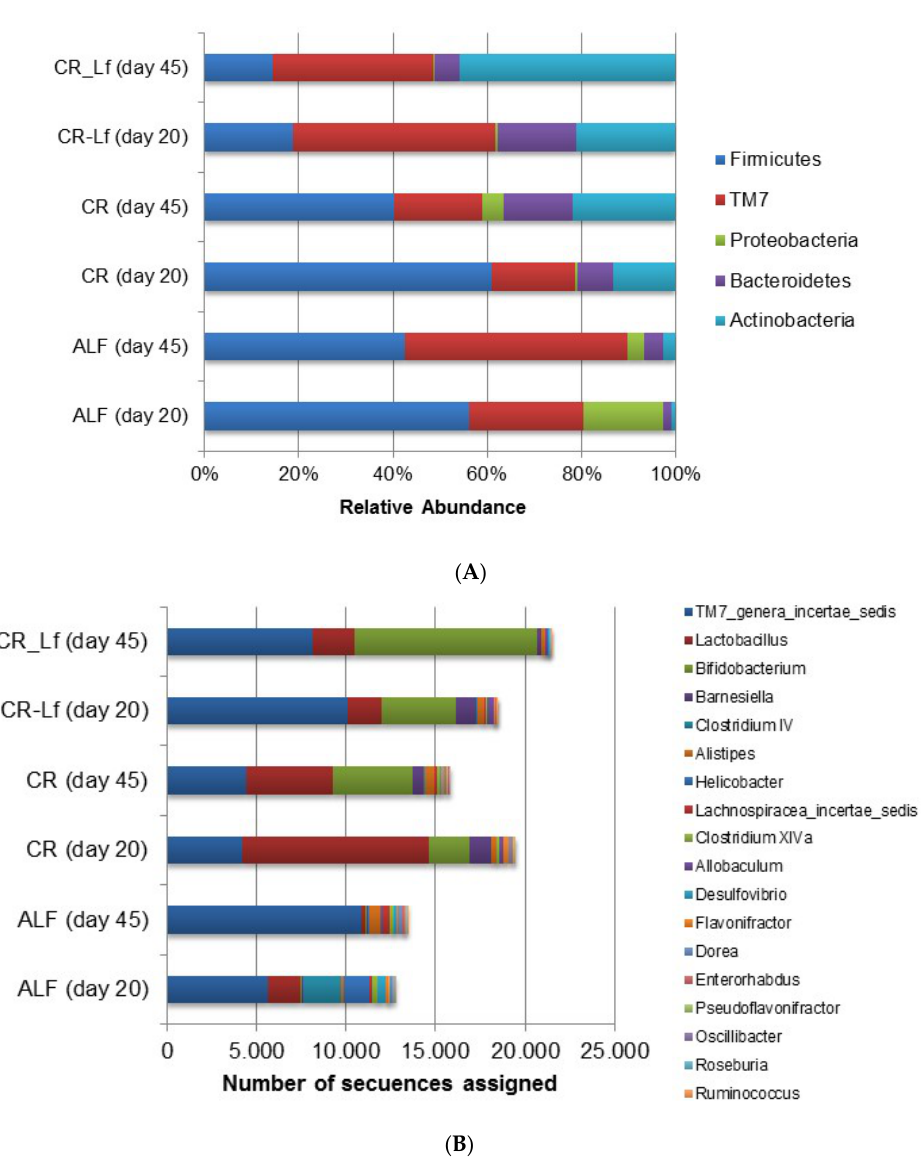
Figure 3. Relative abundance of gut bacterial communities in ad libitum fed and caloric restricted mice: ( A ) phylum level; and ( B ) genus level. ALF Group: ad libitum fed, CR Group: caloric restriction diet, CR ‐ Lf Group: caloric restriction diet plus L. fermentum CRL1446.